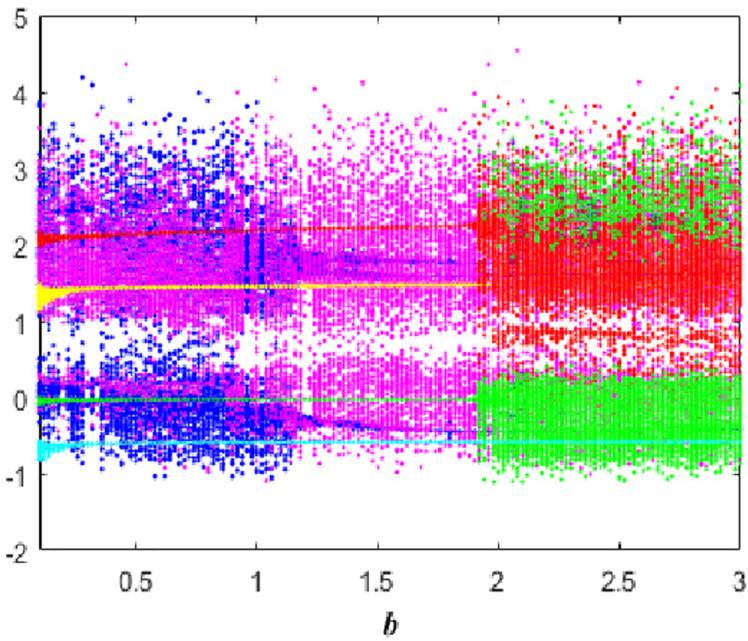
Fig 13. Bifurcation diagram of system (1) versus b starting from: ξ 1 (blue), ξ 2 (red), ξ 3 (green), ξ 4 (magenta), ξ 5 (yellow) and ξ 6